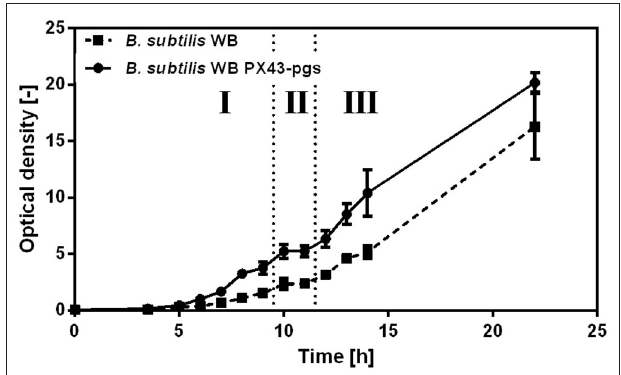
FIGURE 4 | Growth of B. subtilis WB on xylose. Samples for metabolome analysis were taken in the three indicated growth phases. The plateau was observed for B. subtilis WB and B. subtilis WB PX43- pgs , thus independent from γ -PGA production. Cultivations were carried out in triplicates. Data represents the mean of biological triplicates. The error bar indicates the standard deviation.